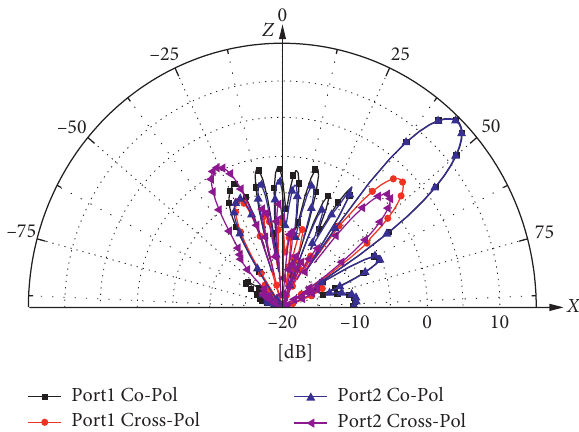
Figure 10: Simulated radiation pattern with the beam steering angles of θ xoz � 45 ° .